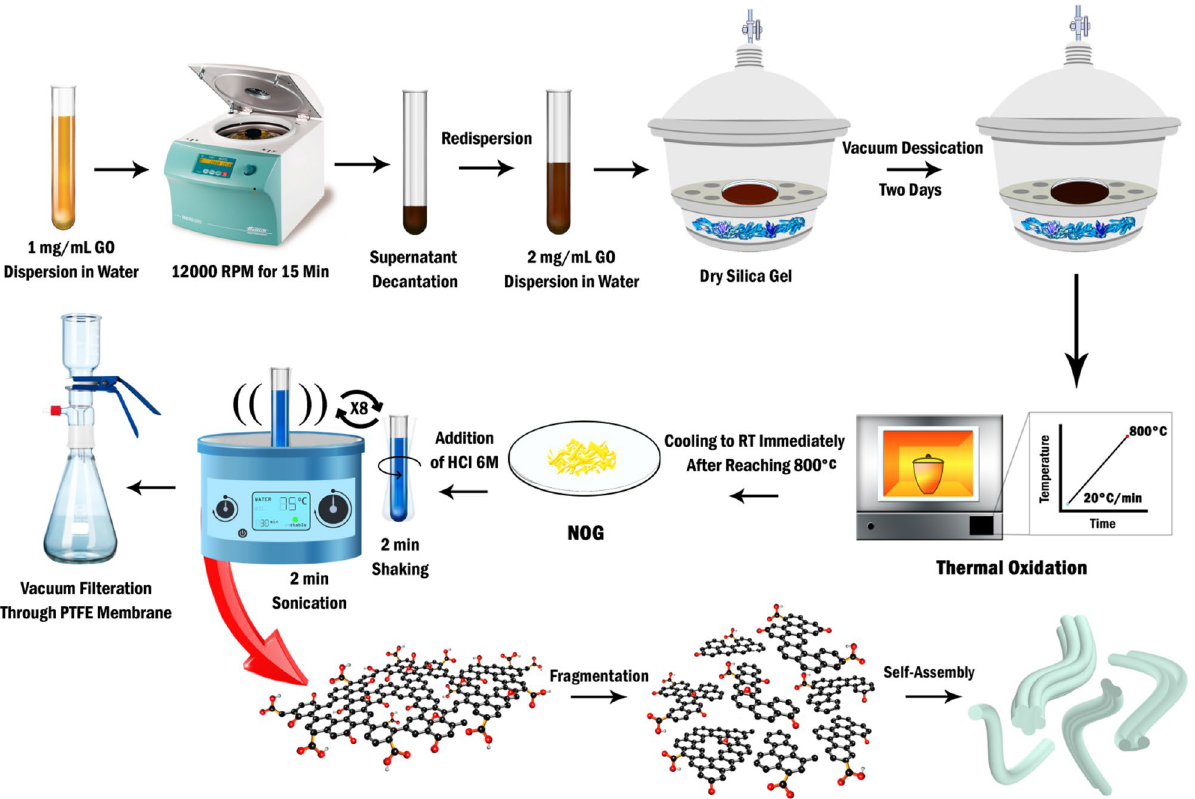
Figure 1. Schematic illustration of the synthetic procedure of NOG nanosheets and the self-assembled NOG